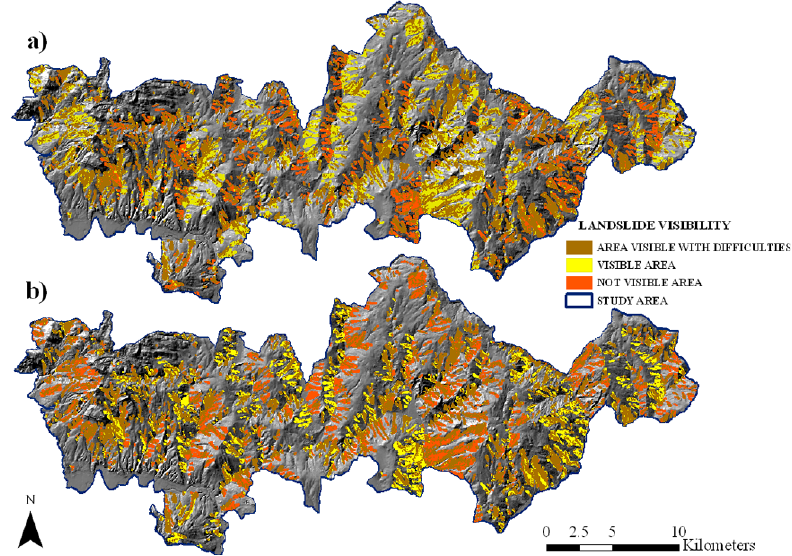
Fig. 13. The a priori landslide visibility map for the study area on descending (a) and ascending (b) orbit.